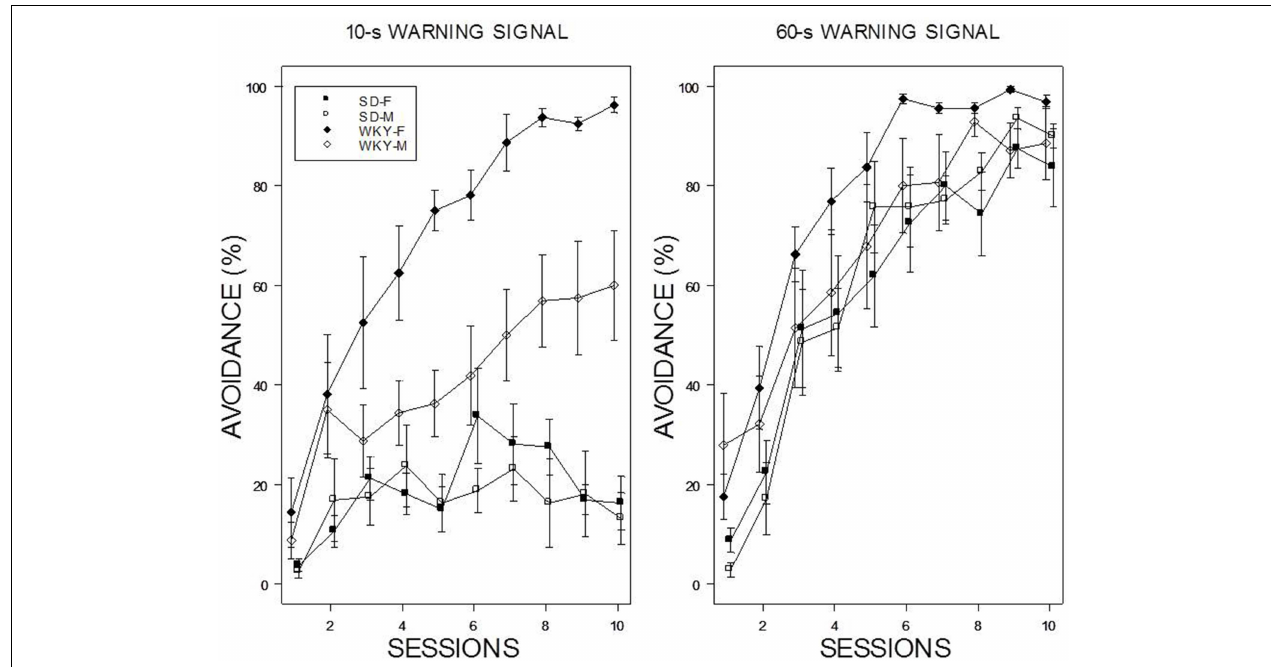
FIGURE 1 | Avoidance acquisition. Avoidance performance using a 10-s WS (left panel) and 60-s WS (right panel). The legend is contained within the figure. Female WKY rats expressed avoidance to a higher